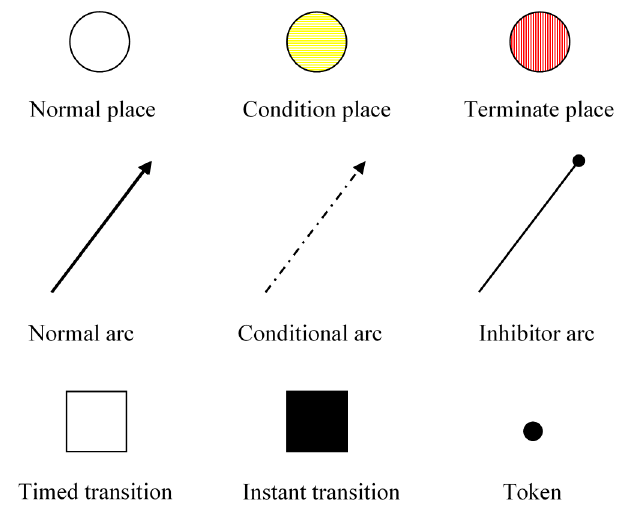
Figure 1. Different symbols used in the Petri net (PN) models.